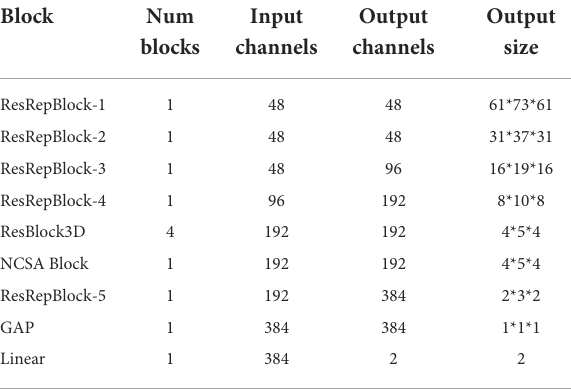
TABLE 1 Architectural specification of the